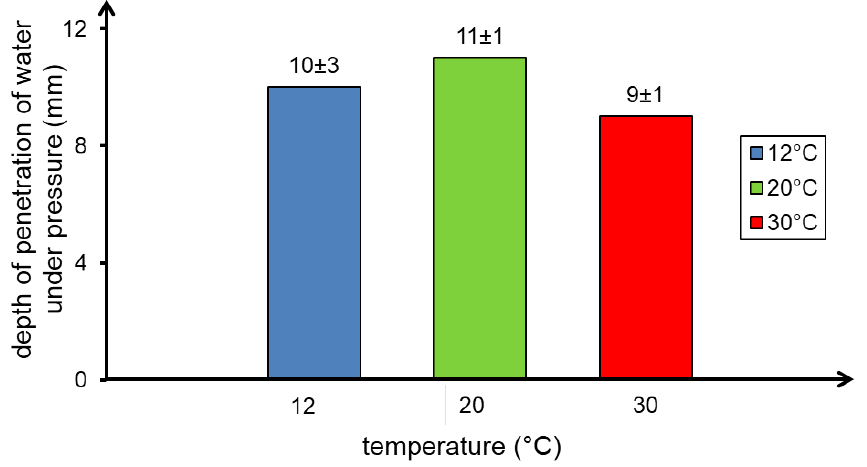
Figure 9. Depth of penetration of water under pressure in concrete samples depending on the curing